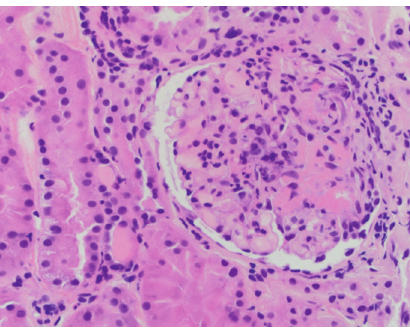
Figure 2: Focal necrotizing crescentic glomerulonephritis on kidney biopsy.